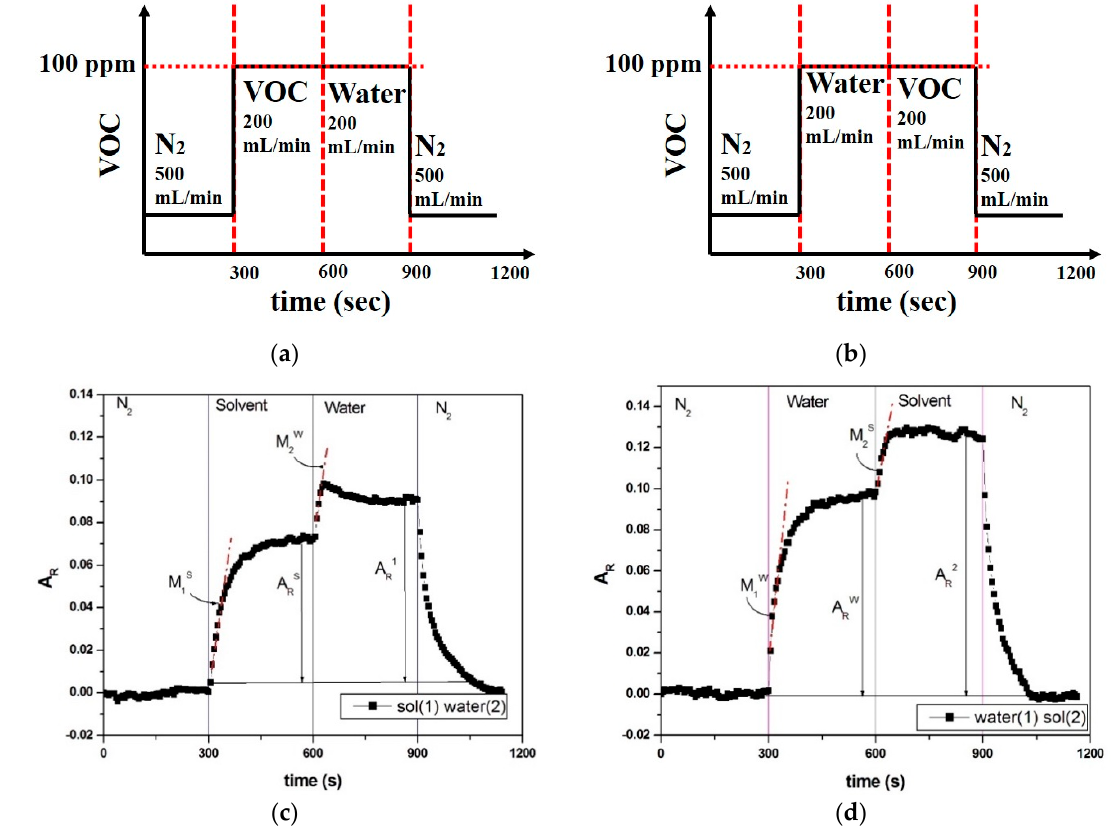
Figure 5. ( a ) Scheme of sequences in experiment 1, ( b ) Scheme of sequences in experiment 2, ( c ) General response of the three sensors exposed successively to 100 ppm of VOC and water vapors, ( d ) General response of the three sensors exposed successively to 100 ppm of water and VOC vapors.